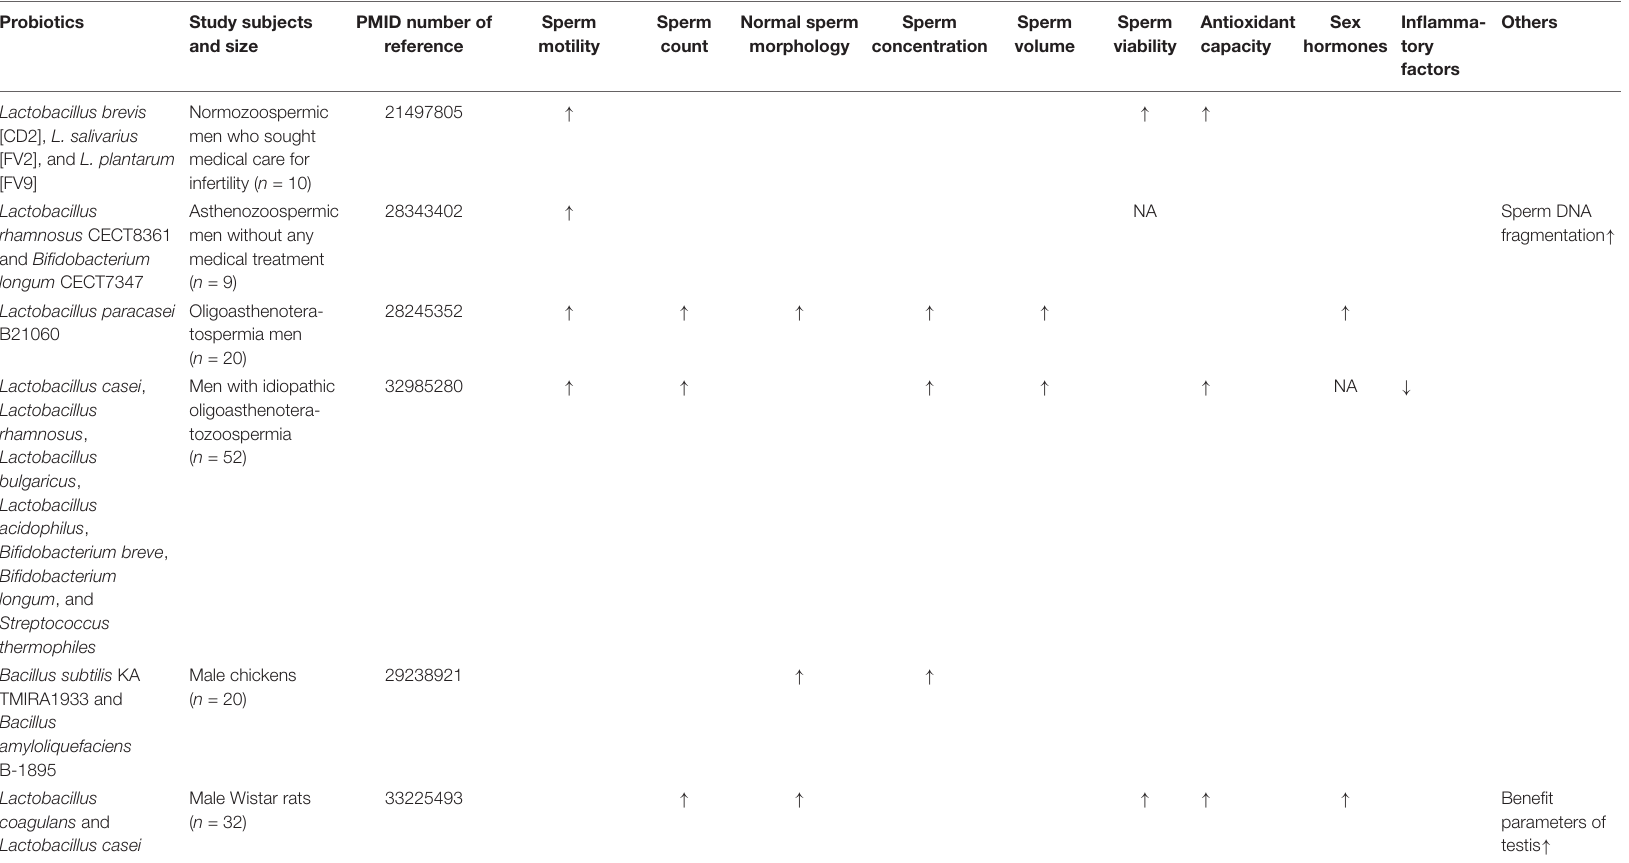
TABLE 2 | Intervention of probiotics on males and their sperm. Probiotics Study subjects